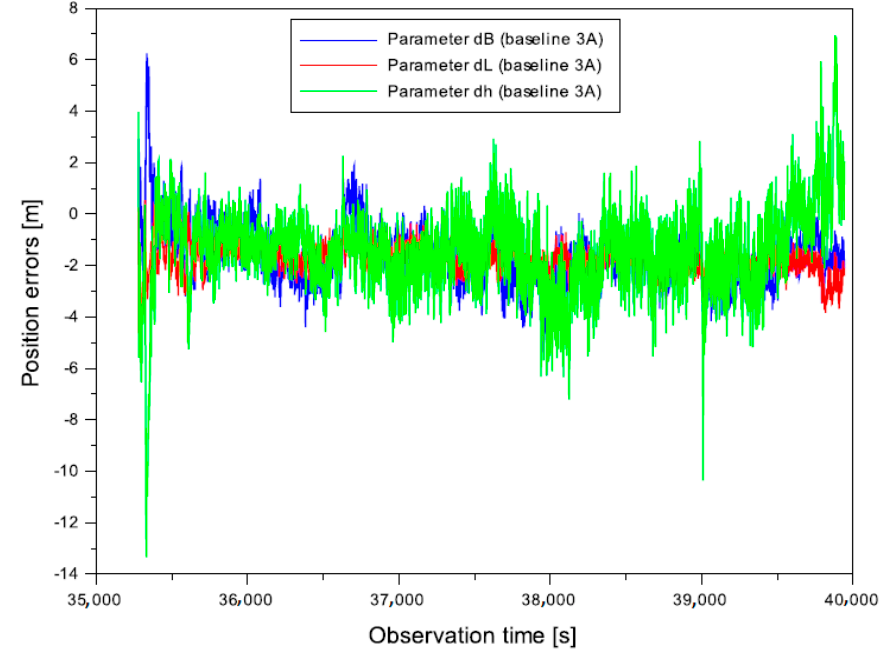
Figure 16. The results of position errors for baseline 3 A .